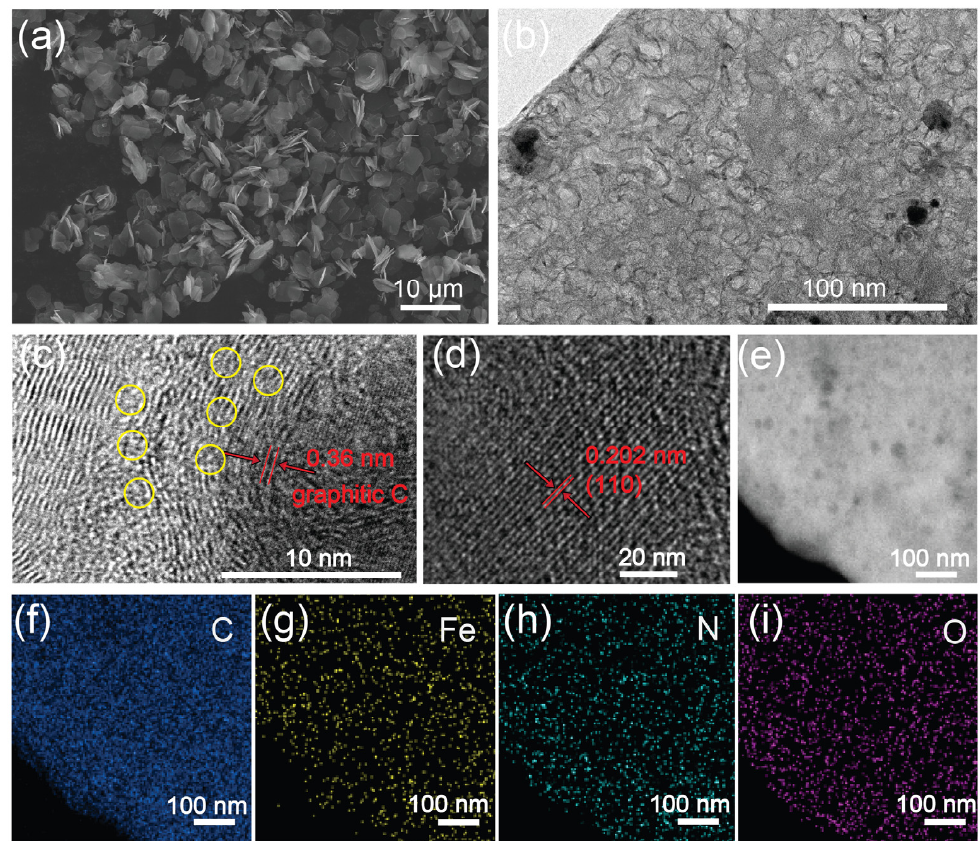
Figure 1. ( a ) SEM image of Fe/NCNS-1; ( b – d ) high-resolution TEM image of Fe/NCNS-1 at different magnifications; ( e – i ) EDS elemental mapping of Fe/NCNS-1.